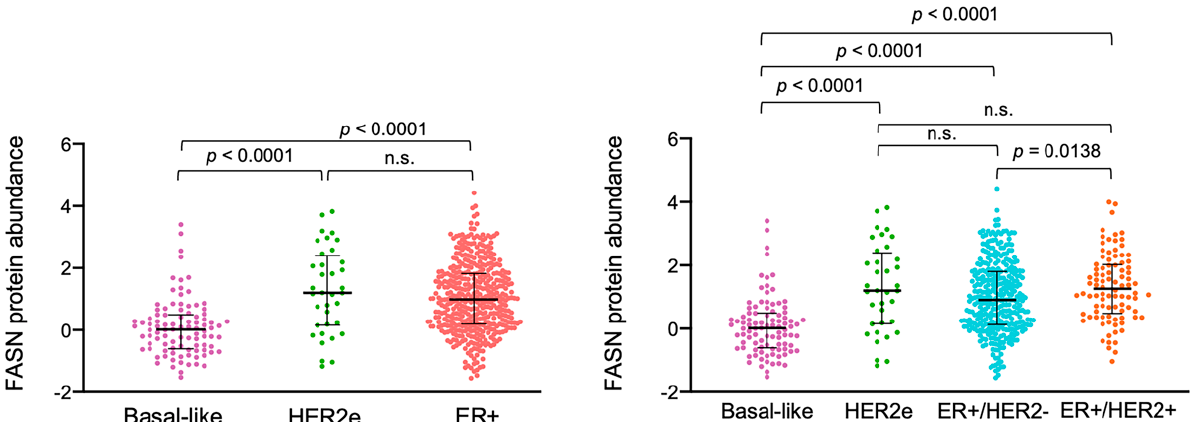
Figure 7. Differential enrichment of FASN protein expression in breast cancer subtypes. FASN protein expression levels in primary breast tumors from The Cancer Proteome Atlas (TCPA, http://tcpaportal.org, accessed on 30 October 2020) were classified into distinct breast cancer subtypes, namely basal-like ( n = 95), HER2-enriched ( n = 36), ER+ ( n = 436), ER+/HER2 − ( n = 344), and ER+/HER2+ ( n = 92). (* p < 0.05, ** p < 0.0001; ANOVA with Dunn’s multiple comparison test). n.s. not significant.